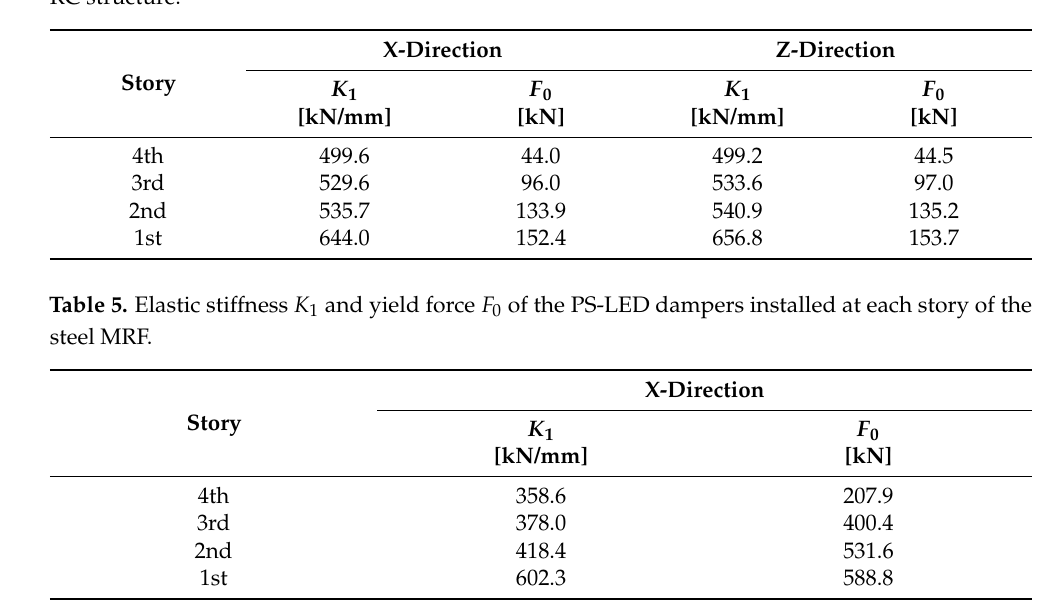
Table 4. Elastic stiffness K 1 and yield force F 0 of the PS-LED dampers installed at each story of the RC structure.